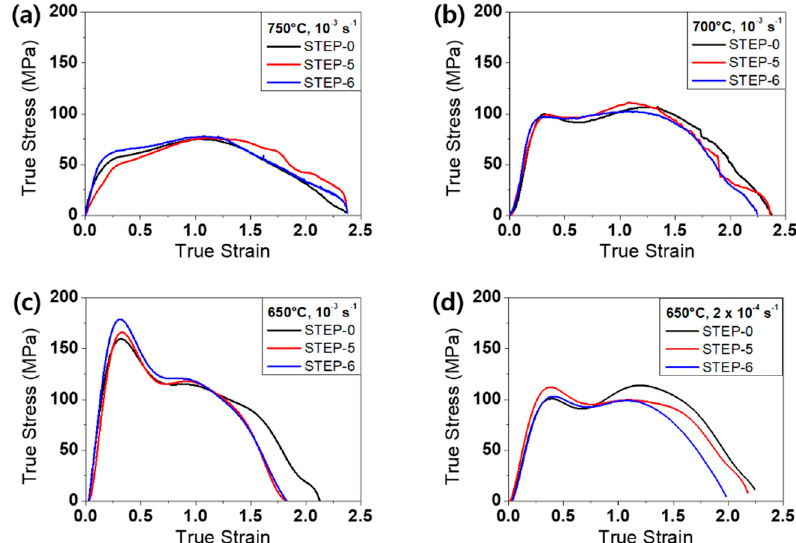
Figure 6. True stress–strain curves of the investigated Ti-6Al-4V alloys at ( a ) 750 °C and strain rate of 10 − 3 s − 1 , ( b ) 700 °C and 10 − 3 s − 1 , ( c ) 650 °C and 10 − 3 s − 1 , and ( d ) 650 °C and 2 × 10 − 4 s − 1 .